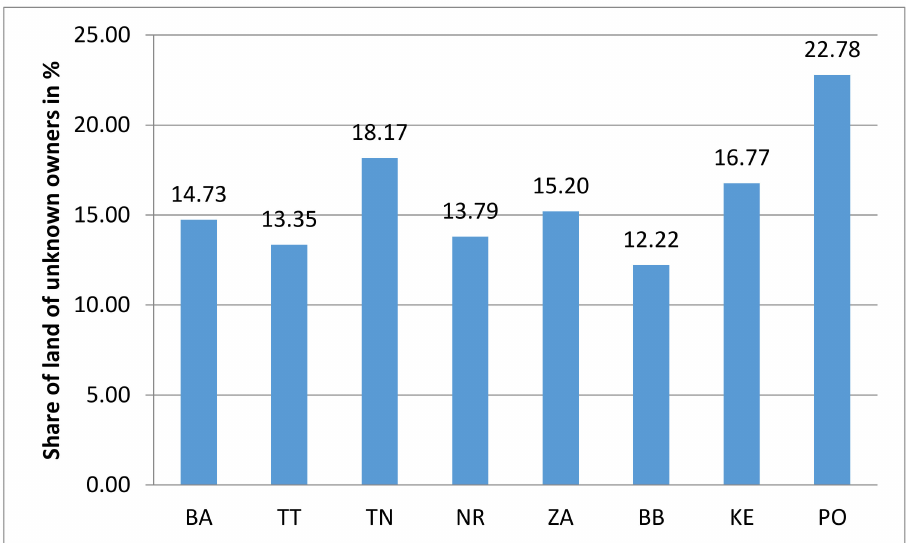
Figure 3. Share of land of unknown owners in the total area of agricultural land in the Slovak regions in 2018. Source: own calculation on the basis of data from Slovak Land Fund, 2018. (Explanation of remarks: the Bratislava region (BA), the Trnava region (TT), the Trenˇc í n region (TN), the Nitra region (NR), the Žilina region (ZA), the Bansk á Bystrica region (BB), the Prešov region (PO) and the Košice region